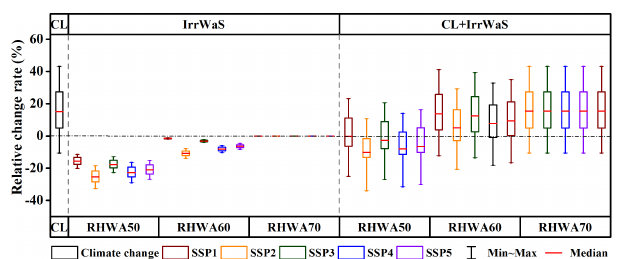
Figure 7. Comparison of relative change of agriculture production with only climate impact (CL), only irrigation water scarcity impact (IrrWaS), and combined climate and irrigation water scarcity impact (CL + IrrWaS) in the YR basin in the 2050s